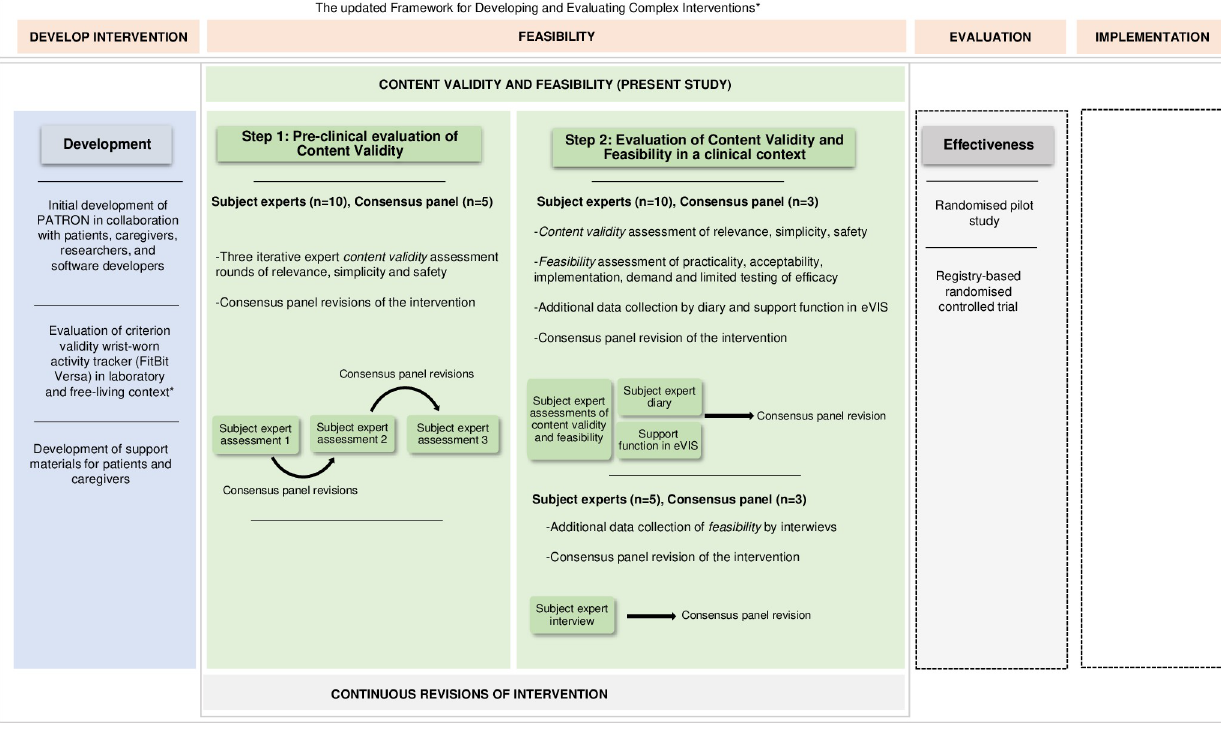
Fig 1. Development, content validity, and feasibility evaluation stages of the eVIS intervention according to the updated Framework for Developing and Evaluating Complex Interventions. � [35] Broken lines illustrate the subsequent phases with effectiveness evaluation and potential implementation.